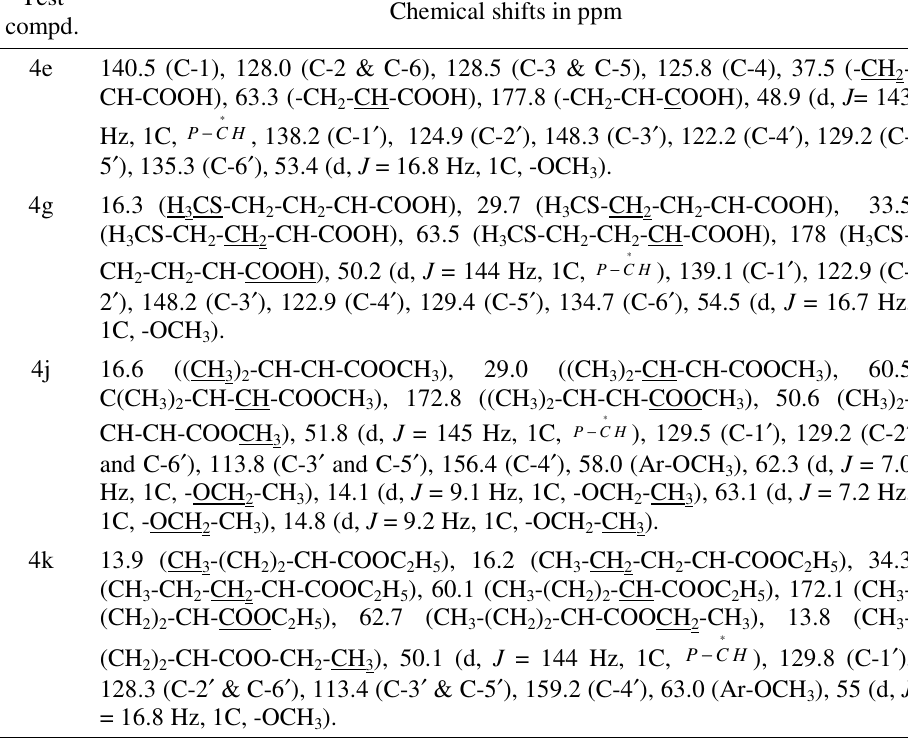
Table 3. 13 C NMR data a,b of 4e, 4g, 4j and 4k Test